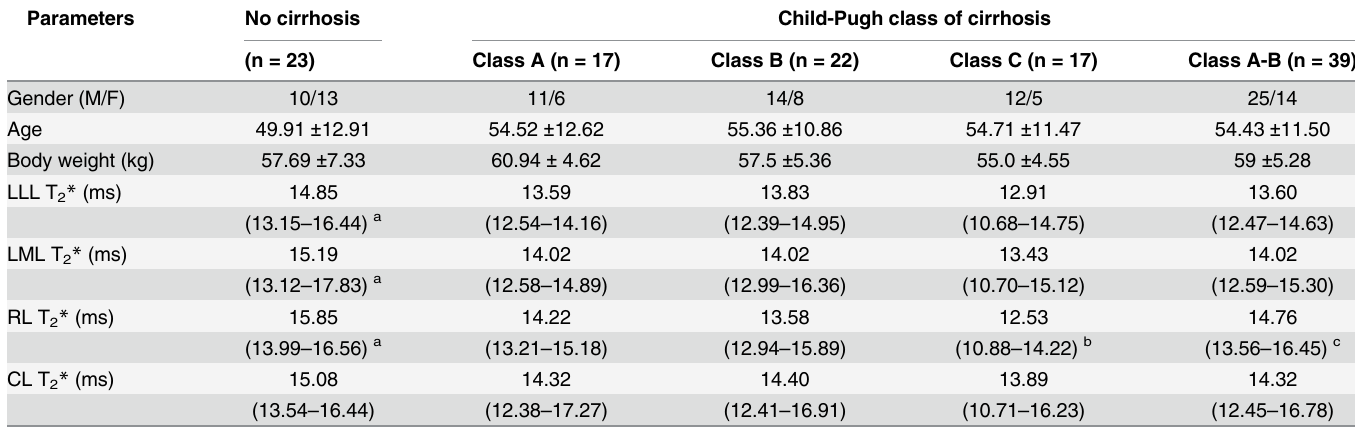
Table 2. Main parameters of the healthy participants and patients with cirrhosis in different Child-Pugh classes.